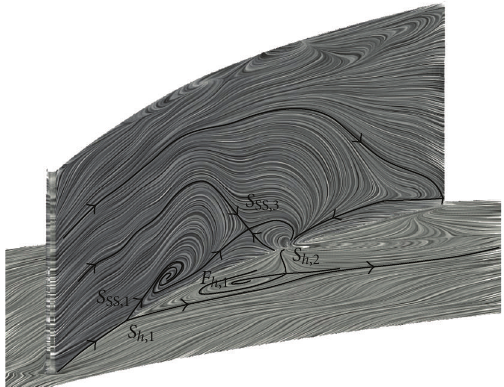
Figure 14: Snapshot of the time-varying skin-friction pattern. Existence of a two-focus topology; operating point D.